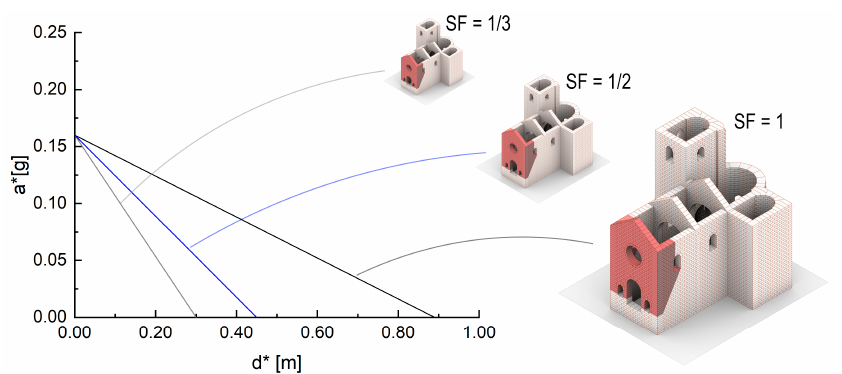
Figure 12. Comparison in terms of capacity curves of the three idealized configurations.